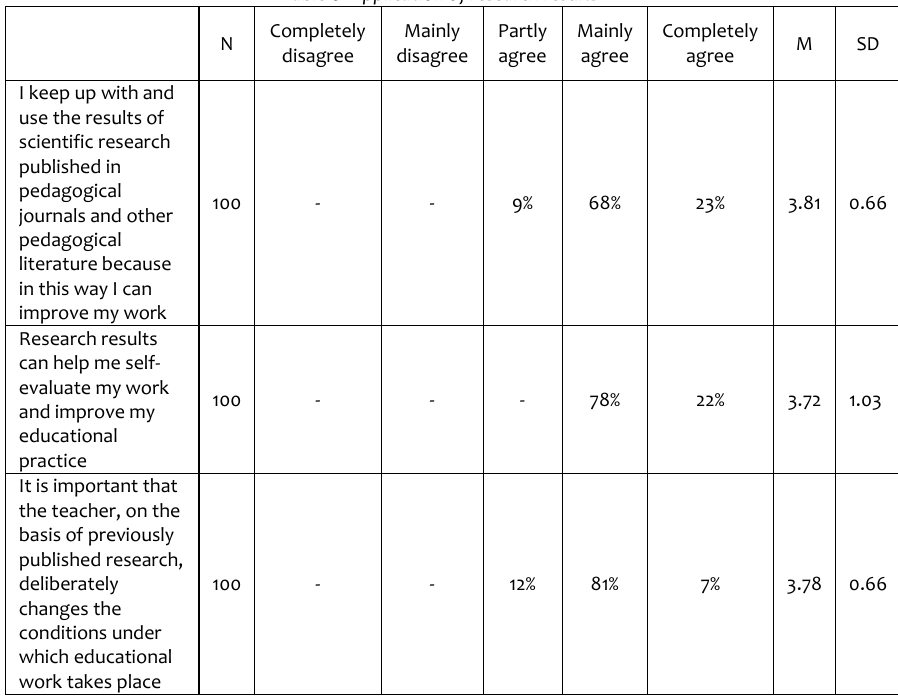
Table 6: Application of research results